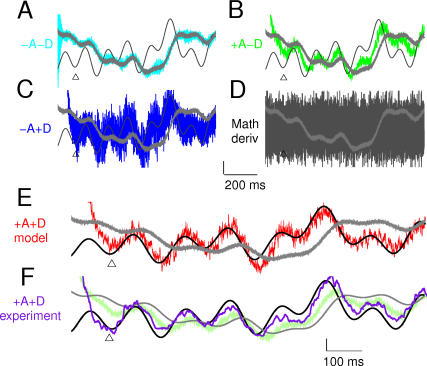
The Network Computed the Rate of Change of an Arbitrary Input, Ignoring High-Frequency Fluctuations(A–E) Same network model as in Figure 1A. All presynaptic model cells receive the same I
in = I
signal + I
noise (gray), with I
signal the sum of low-frequency sinusoids (see Materials and Methods) and I
noise a Gaussian white noise. Panels show I
post for different combinations of SFA and STD. Colors and symbols as in Figure 1. The derivative of I
signal is plotted (black) to compare with I
post. Unlike the mathematical derivative shown in (D), SFA plus STD (E) acted as a pass-band filter differentiator.(F) Smoothed I
post for experimentally measured synapses (purple) is also very close to the derivative of I
signal (all signals equally smoothed for fair comparison). The response of an SFA-only network is superimposed for comparison (pale green). Vertical scale bars = 1 s.d.